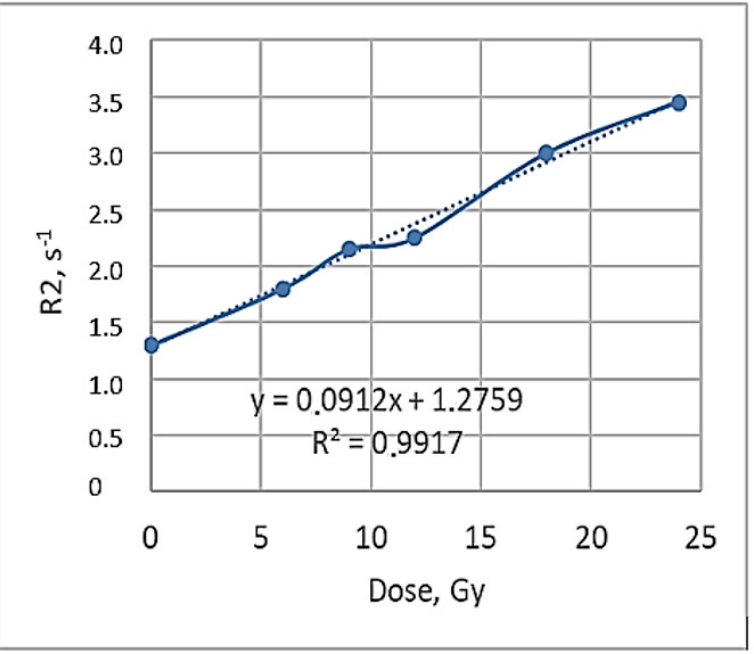
Figure 9. Relaxation rate R2-related dose sensitivity curve of irradiated gels evaluated by MRI 56 h post-irradiation.